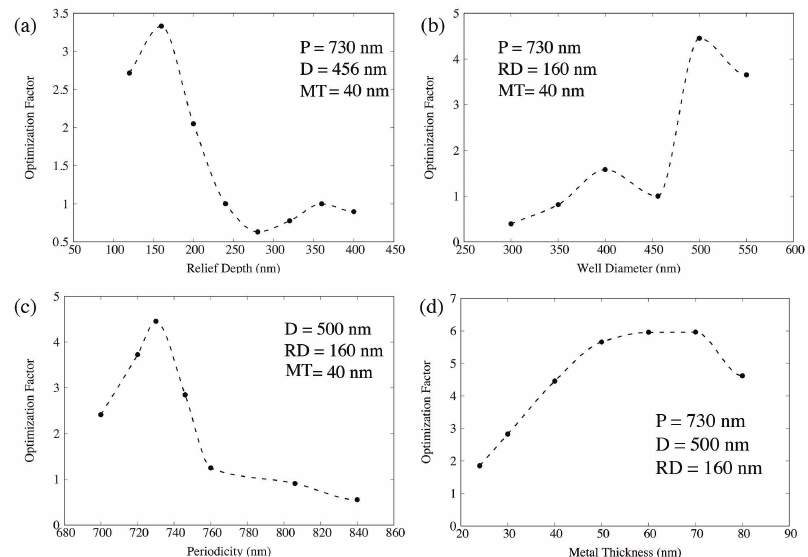
/ G 4 ) as nanowell ( a ) relief depth, ( b ) diameter, SERS control